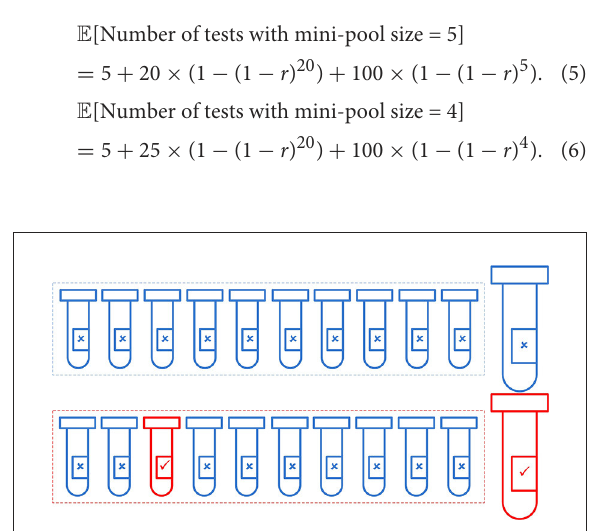
FIGURE3 Illustration of the use of the pooling method to identify all the infected individuals in a group of 20, using pools with a size of 10. Assuming that one individual is infected ( r pooled tests 10 individual tests) tests are required to identify + all individuals.